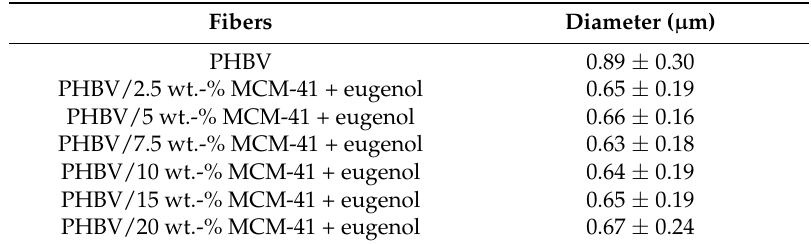
Figure 2. Scanning electron microscopy (SEM) images of the electrospun fibers of poly(3-hydroxybutyrate- co -3-hydroxyvalerate) (PHBV)/Mobil Composition of Matter (MCM)-41 with eugenol: ( a ) Neat PHBV; ( b ) 2.5 wt.-% MCM-41 + eugenol; ( c ) 5 wt.-% MCM-41 + eugenol; ( d ) 7.5 wt.-% MCM-41 + eugenol; ( e ) 10 wt.-% MCM-41 + eugenol; ( f ) 15 wt.-% MCM-41 + eugenol; ( g ) 20 wt.-% MCM-41 + eugenol. Scale markers of 10 µ m. Table 1. Mean diameters of the electrospun fibers of poly(3-hydroxybutyrate- co -3-hydroxyvalerate) (PHBV)/Mobil Composition of Matter (MCM)-41 with eugenol.